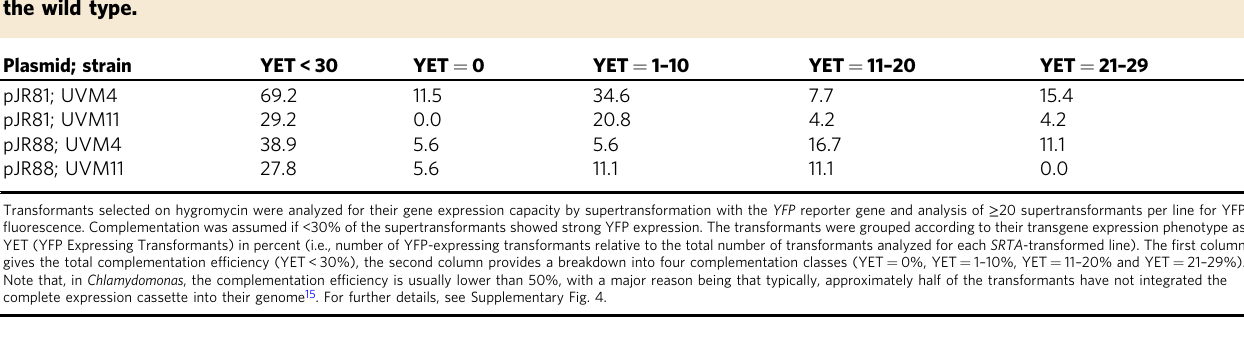
Table 1 Introduction of the SRTA wild-type allele into UVM4 and UVM11 restores the poor transgene expression phenotype of the wild